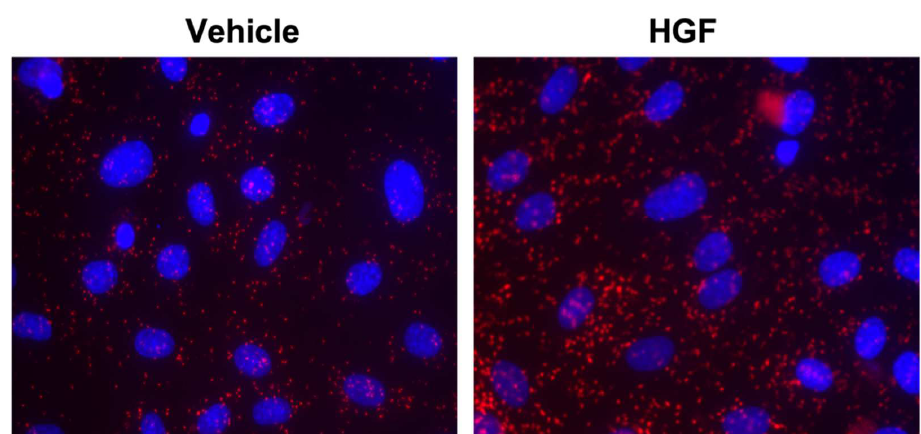
Figure 1. In vitro analyses showing interaction of cortactin with MLCK in lung endothelial cells. Serum starved HPAECs were incubated with either control vehicle or HGF for 5 min, and then the association of MLCK and CTTN was detected using in situ proximity ligation assay (red dots). Representative images are shown. Table 1. Representative key proteins that interact with CTTN .